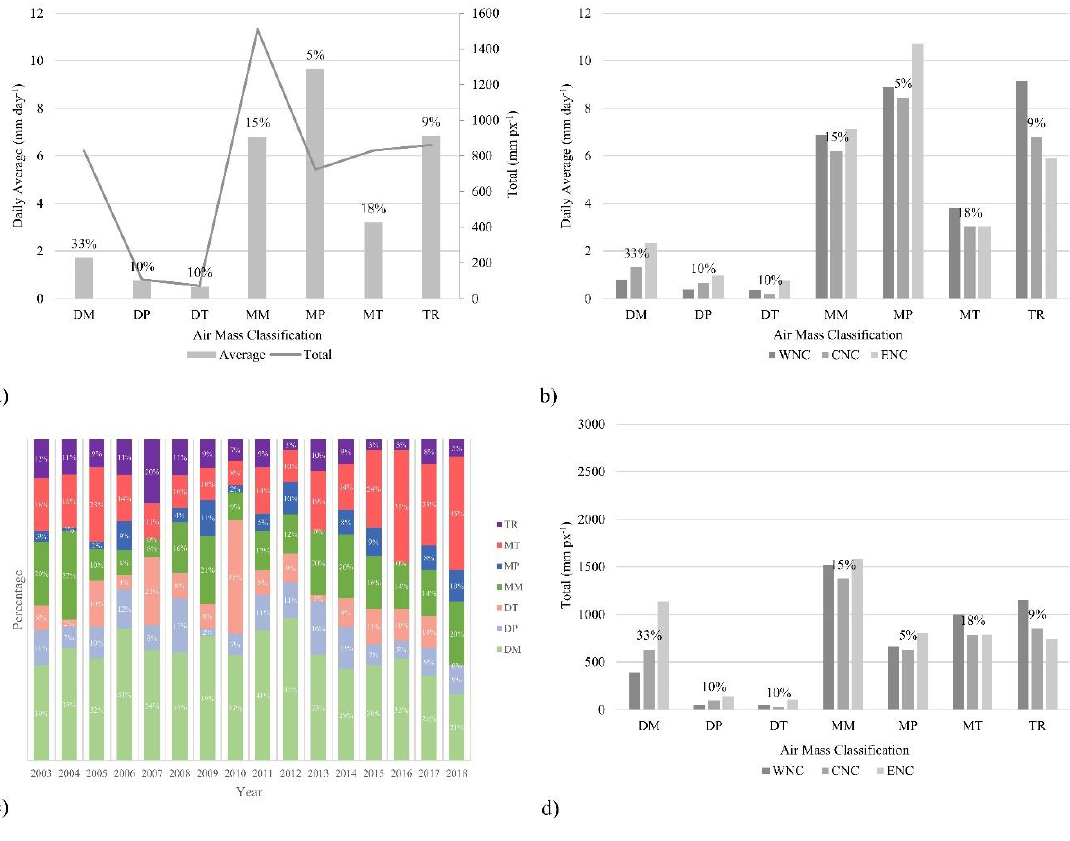
Figure 10. ( a ) fall (SON) statewide daily average precipitation and total precipitation for each SSC air Figure 10. Same as Figure 4 but for fall (SON). mass classification; ( b ) daily average precipitation for each North Carolina region; ( c ) frequency of each SSC air mass classification over the study period; ( d ) total precipitation for each North Carolina region. Percentages indicate the fraction of air mass classification for each season ( a , b , d ) or year ( c ). Totals are presented as millimeters per pixel (mm px − 1 ), which is equivalent to millimeters per grid